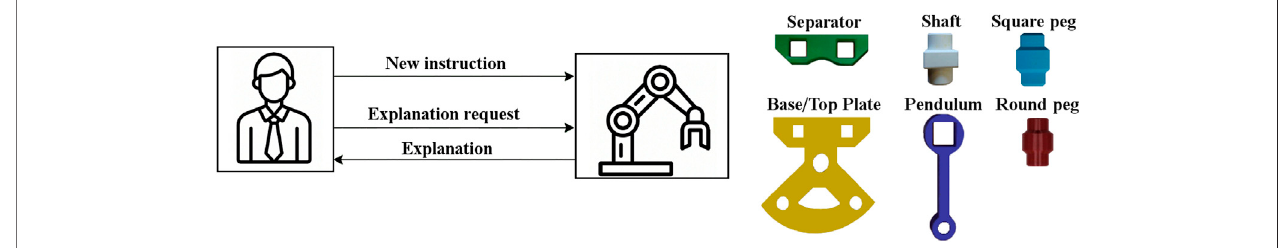
FIGURE1| Thearchitectureoftheproposedmethodology(left)andobjectsoftheCran fi eldbenchmark(right).Thehumanpartnerisabletoseethecobot ’ saction and assembly state. Further, the human partner can ask the cobot to explain its actions, which leads to the cobot producing a sentence to explain the reason for the performed action (Section 3.1) . In addition, the human partner can directly teach a new instruction to the cobot to enable it to restart the learning procedure with more knowledge about the task, which eventually enables it to complete the task (Section 3.2) .